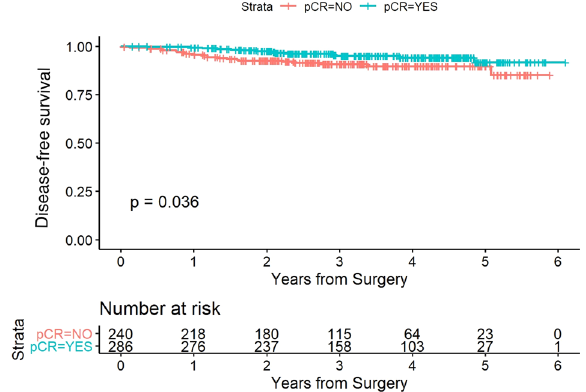
Fig. 3 Disease-free survival strati fi ed in pCR versus non-pCR groups. The red and blue curves show the estimated disease-free survival of the patients in the non-pCR group and pCR group, respectively.